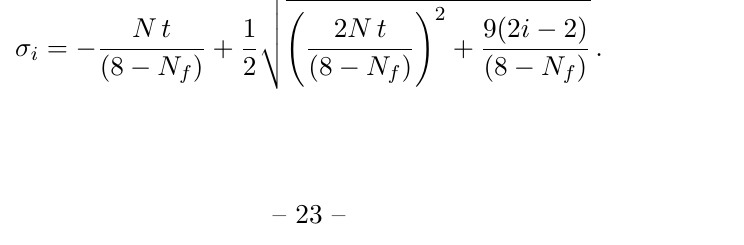
= − . 1 and N = 150 eff